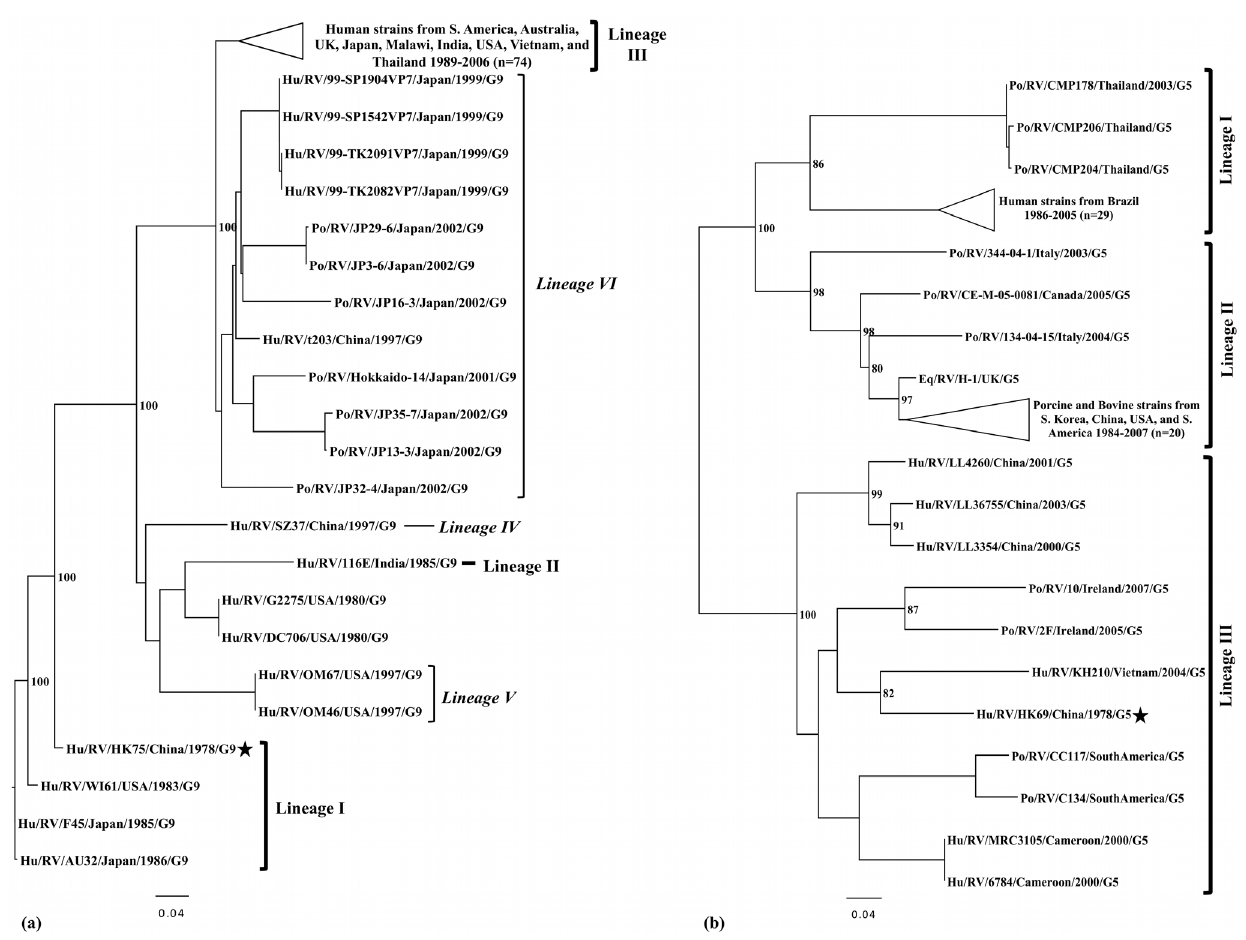
Figure 3. Phylogenetic analyses of partial VP7 capsid nucleotide sequences from rotaviruses. Bootstrap values are shown as percent values for major nodes, and large clusters are collapsed. Black stars indicate sequences obtained from this study. (a) Inferred phylogeny for G9 rotaviruses as determined by a maximum likelihood phylogenetic analysis, including previously defined lineages. Bold brackets indicate consistently defined lineages I, II, and III. Subclusters within lineage III, described by Matthijnssens et al. , are indicated in italics, and lineages IV, V, and VI, described by Martinez-Laso et al. , are also listed. Strains Hu/RV/G2275/USA/1980/G9 and Hu/RV/DC706/USA/1980/G9 are of indeterminate lineage. (b) Inferred phylogeny for G5 rotaviruses as determined by a maximum likelihood phylogenetic analysis, including previously defined